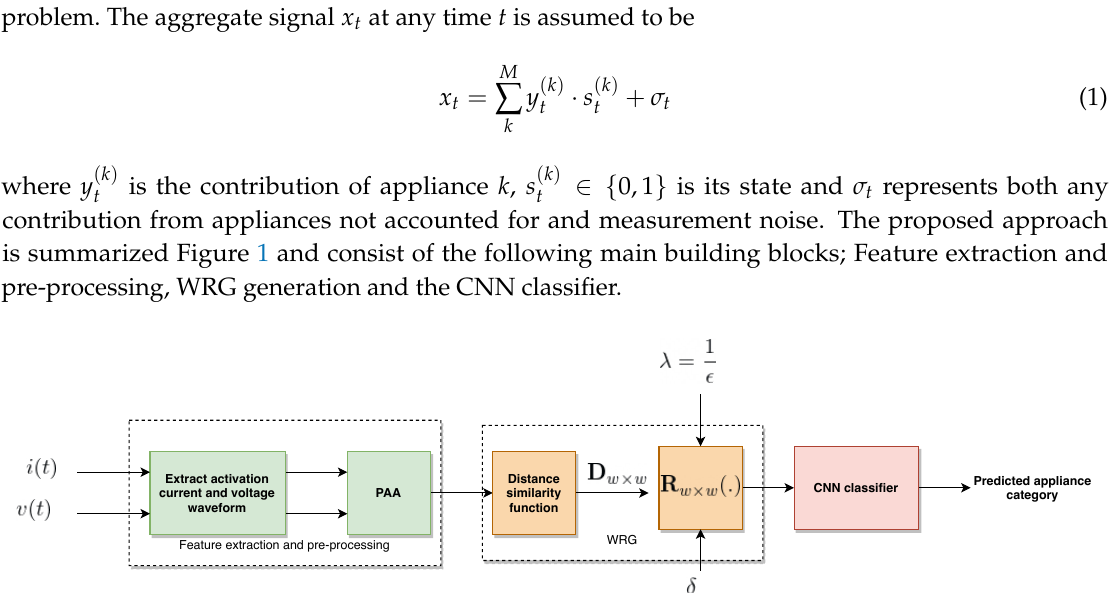
Figure 1. Block diagram of the proposed approach. It consist of the Feature extraction and pre-processing, WRG generation and the CNN classifier